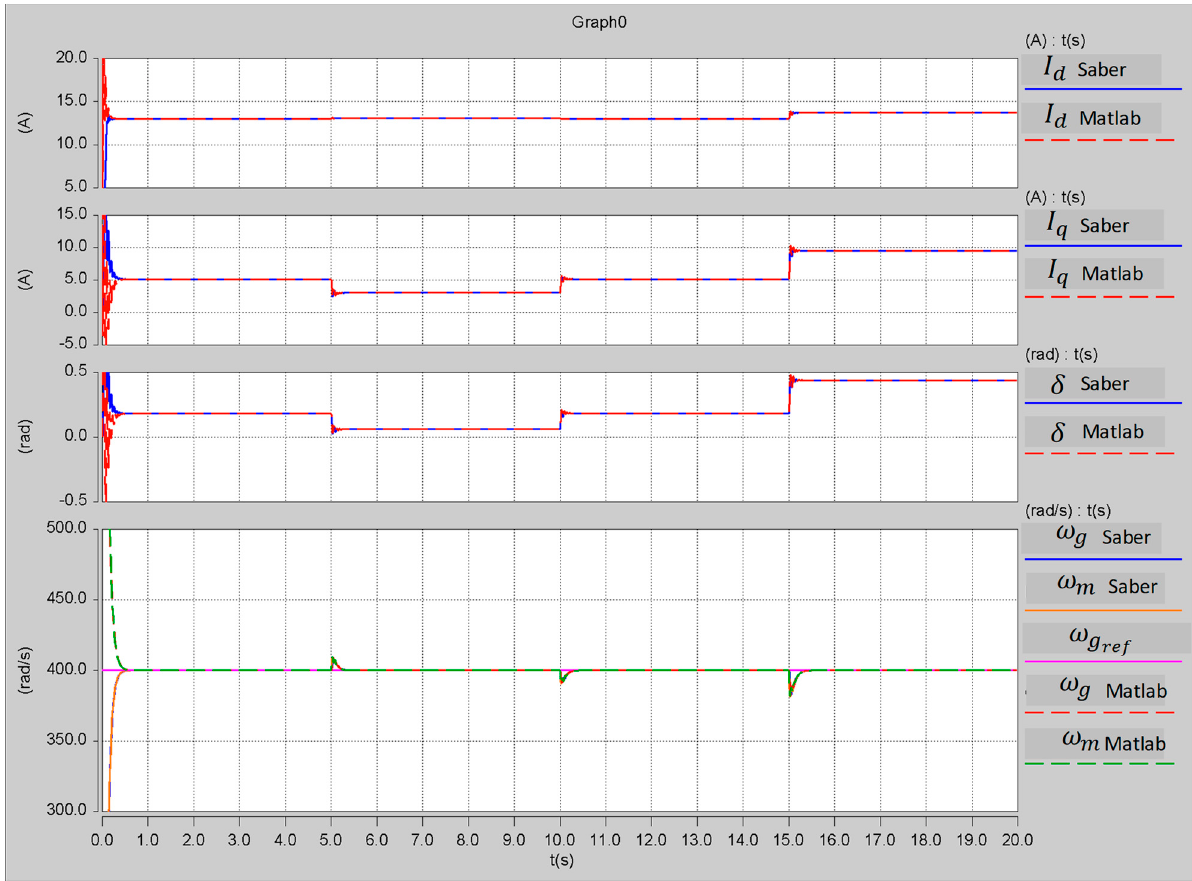
Figure 5. Comparison of time simulations between the analytic state model simulated on Matlab Simulink (red curves) and the circuit simulation on Saber (blue curves).